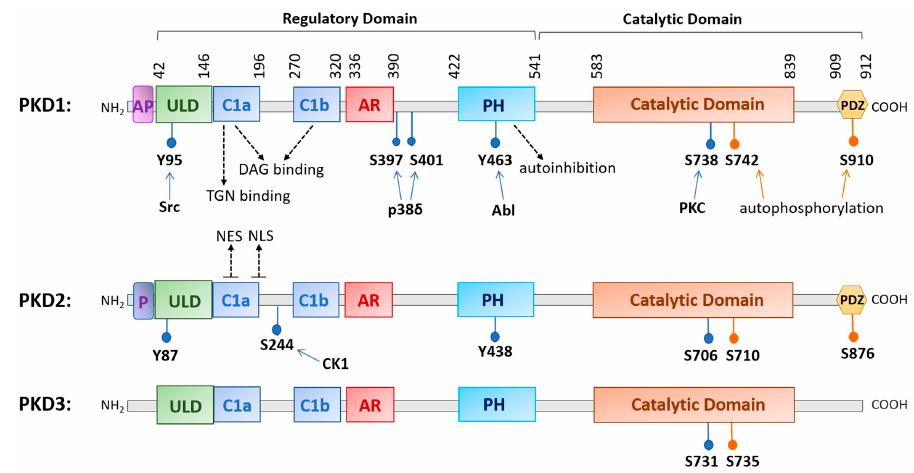
Figure 1. A diagram illustrating the conserved structural domains and major phosphorylation sites in human protein kinase D (PKD) isoforms. The structure of PKD contains a newly identified ubiquitin-like domain (ULD) for dimerization, a C1 domain (Cla and Clb) that binds diacylglycerol, a pleckstrin homology (PH) domain for autoinhibition, a catalytic domain for substrate phosphorylation, and a PDZ domain in PKD1 and PKD2 for protein interactions. Other domains with less known functions are the acidic amino-acid-rich region (AR) and an alanine–proline-rich region (AP) for PKD1 and a proline-rich region (P) for PKD2. Major phosphorylation sites and the upstream kinases that confer the phosphory- lation are indicated as well as the nuclear export signal (NES) and nuclear localization signal (NLS) for PKD2. Abbrevia- tions: trans-Golgi network (TGN), Abelson murine leukemia viral oncogene homolog 1 (Abl), casein kinase 1 (CK1). 2.2. Mechanisms of Regulation PKD can be activated downstream of GPCRs or receptor tyrosine kinases (RTKs) by a variety of stimuli such as hormones, growth factors, neuropeptides, lipids, and cellular stresses [7]. In a canonical activation pathway, following receptor stimulation, phospho- lipase Cs (PLCs) are activated to hydrolyze phosphatidylinositol 4,5-biphosphate (PIP2) to generate inositol 1,4,5-trisphosphate (IP3) and DAG. IP3 mobilizes internal calcium and DAG along with calcium (for cPKC) binds and anchors classic or novel protein kinases C (c/nPKC) to the plasma membrane and triggers their activation. DAG also recruits cyto- solic PKD to the plasma membrane by binding to its C1 domain; this process may induce a conformational change that allows PKC to colocalize with PKD at the plasma membrane to transphosphorylate a conserved serine residue (Ser 738 for PKD1, Ser 706 for PKD2, Ser 731 for PKD3) in the activation loop of PKD, leading to the autophosphorylation of an adjacent serine residue (Ser 742 for PKD1, Ser 710 for PKD2, and Ser 735 for PKD3) and relief of autoin- hibition by the PH domain for full activation of the kinase [15–17]. Given the lack of crystal structure of PKD, there remain many questions regarding the exact sequence of events occurring during the activation of PKD by DAG and PKC, particularly in light of the dis- covery of a N-terminal ULD domain (see detailed discussion in ref. [5]). PKD can be activated at multiple subcellular locations and can also be mobilized to different cellular compartments to carry out unique functions at each site (Figure 2). PKD was first identified as a trans-Golgi network (TGN)-resident enzyme [18]; a series of land- mark studies by the Malhotra group shows that PKD plays a critical role in regulating the fission of transport carriers from TGN to the cell surface [19–21]. As with its activation at the plasma membrane, PKD is recruited by DAG to the TGN [22]. An intact C1a domain and the catalytic activity of PKD are both required for its binding and regulation of vesicle